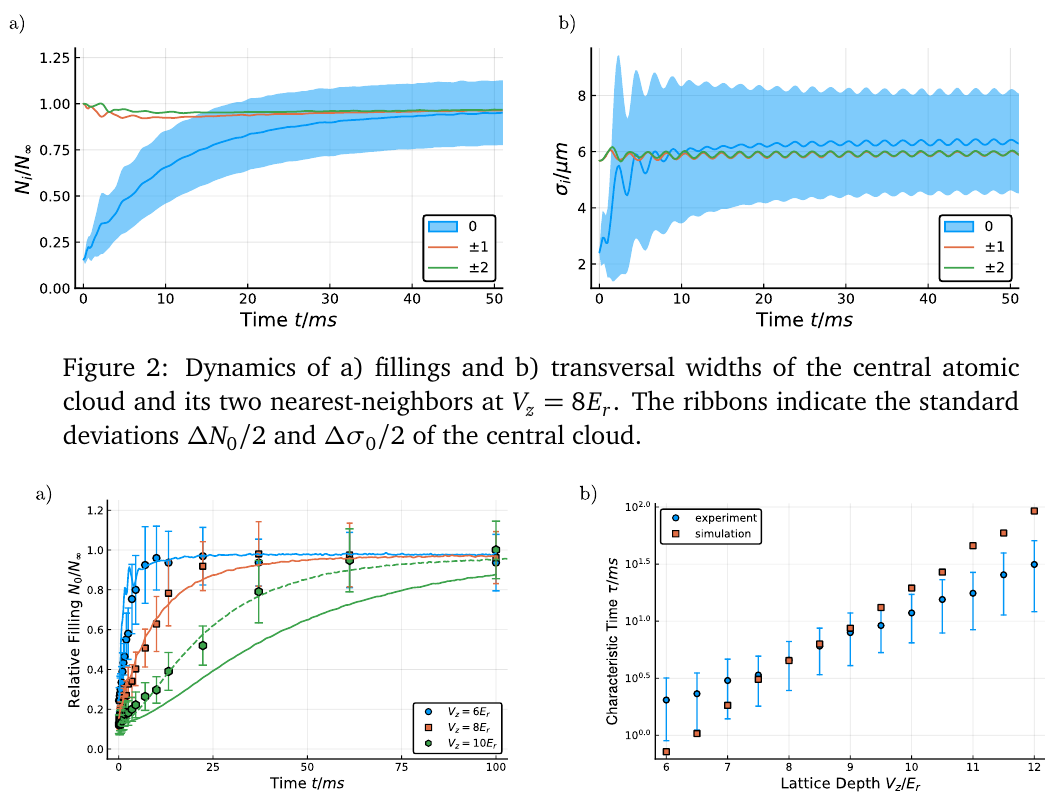
Figure 3: Refilling dynamics of the initially empty site. a) Comparison of the re- filling dynamics of the simulation (solid lines) and the experiment. The additional dashed green line is equivalent to the solid green line but with the effective time = 0.54 t chosen to fit the experiment. b) Characteristic filling times τ of the sim- t eff ulation (squares) and experiment (circles) obtained by fitting the logistic function Eq. (35) to the